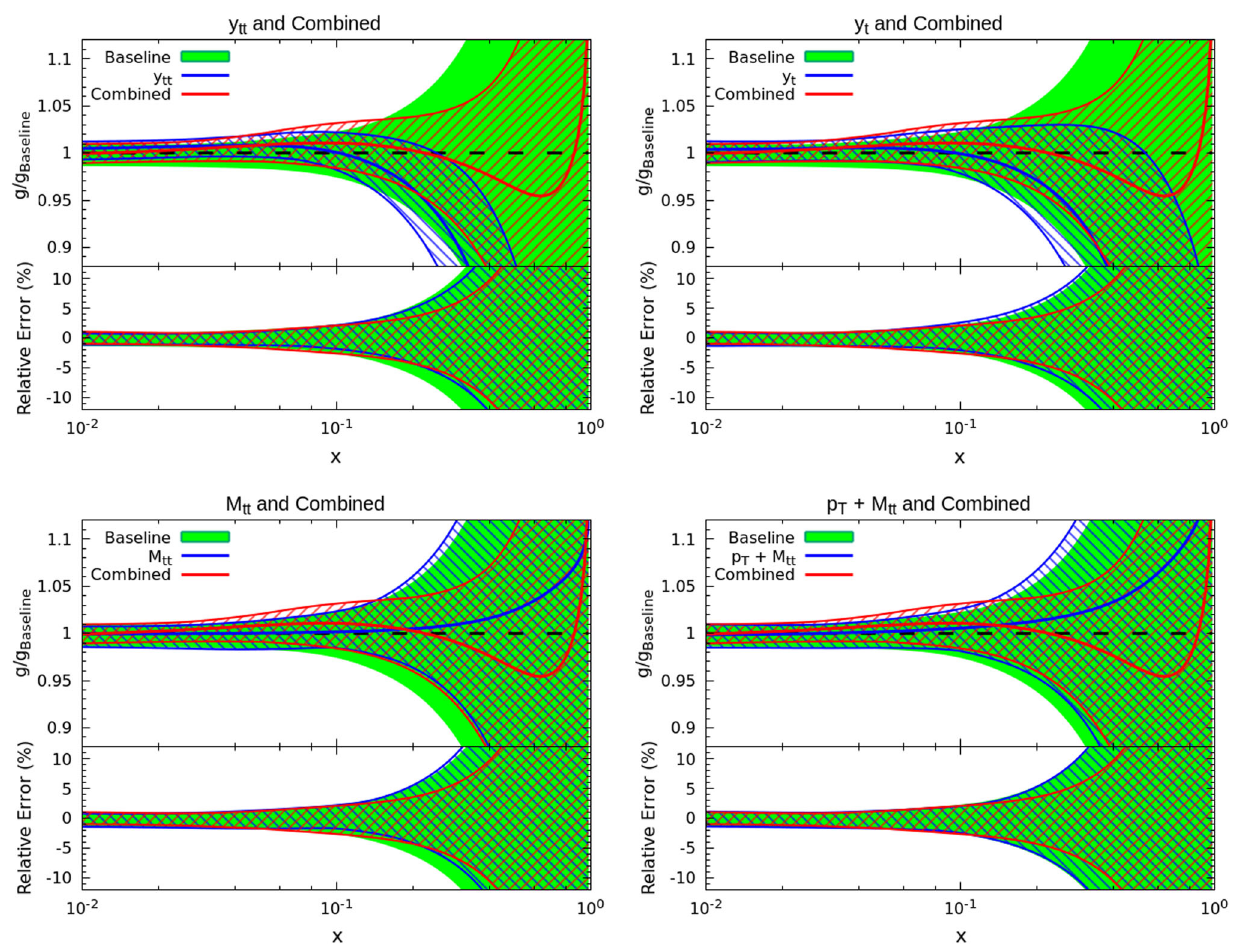
Fig. 1 Impact of the ATLAS 8 TeV lepton + jet data on the gluon PDF. Results for fits to individual distributions as well as the combined p T + M tt case are shown, while the result from a combined fit to all four distributions is shown for comparison in all cases